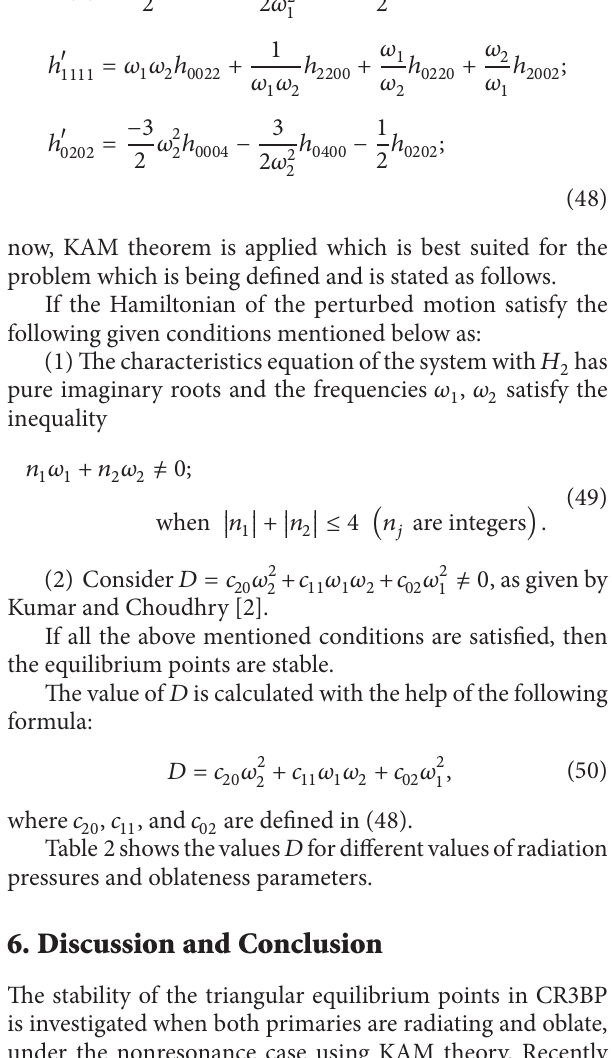
Table 2: Values of 𝐷 at different values of eccentricity for different values of radiation pressure and oblateness